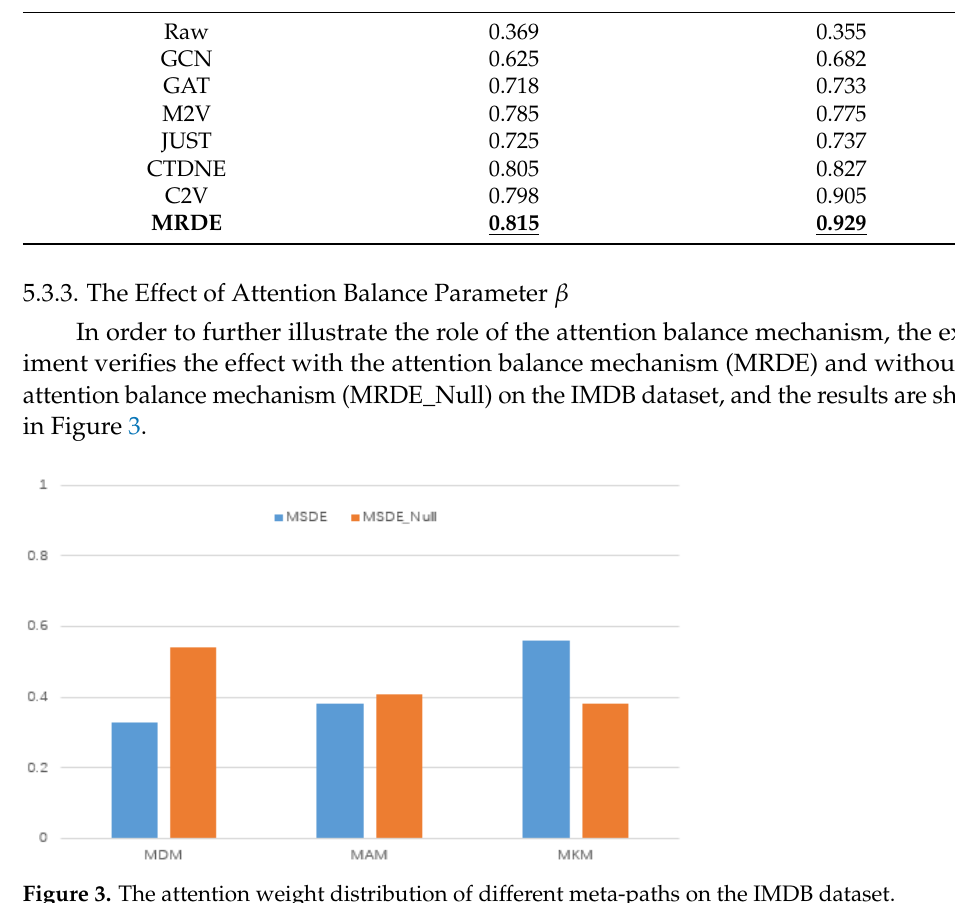
11 of 17 Table 3. Experimental results of node clustering task. Method